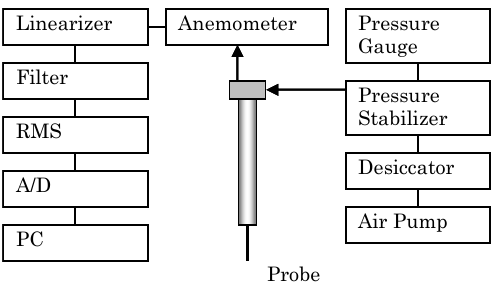
Fig. 2 Static pressure measuring system.